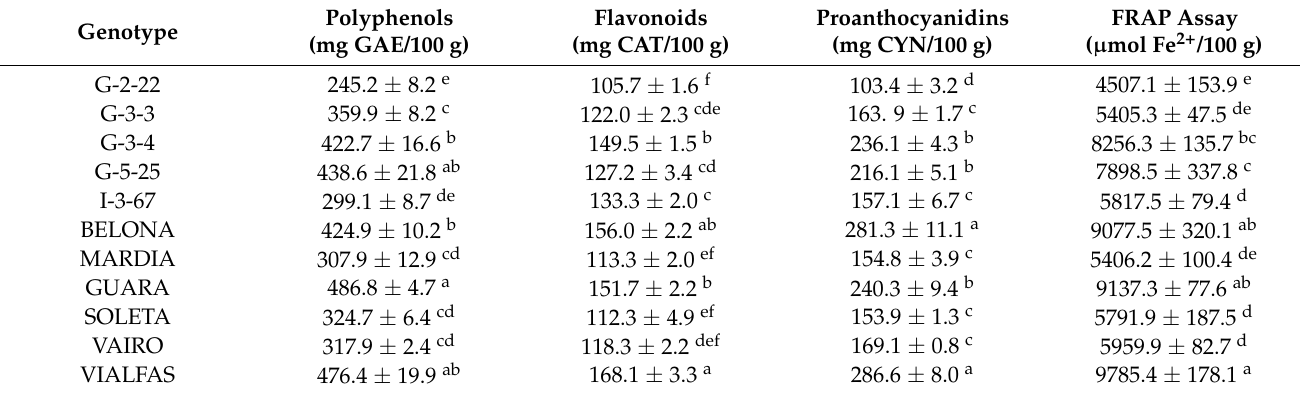
Table 5. Total results of polyphenols, flavonoids, proanthocyanidins and antioxidant capacity in the samples.